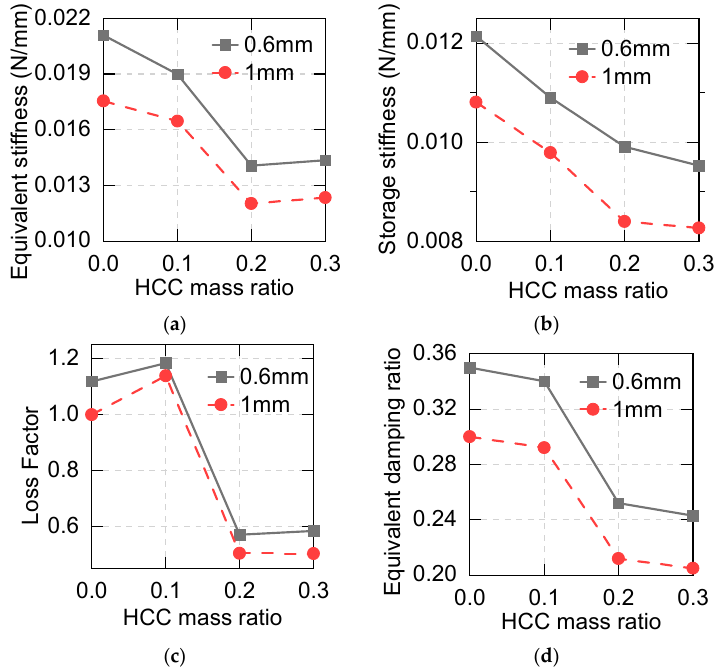
Figure 11. Dependence of the damping properties of asphalt on the HCC mass ratio with a temperature of 20 °C and a loading frequency of 0.1 Hz: ( a ) equivalent stiffness; ( b ) storage stiffness; ( c ) loss factor; ( d ) equivalent damping ratio.